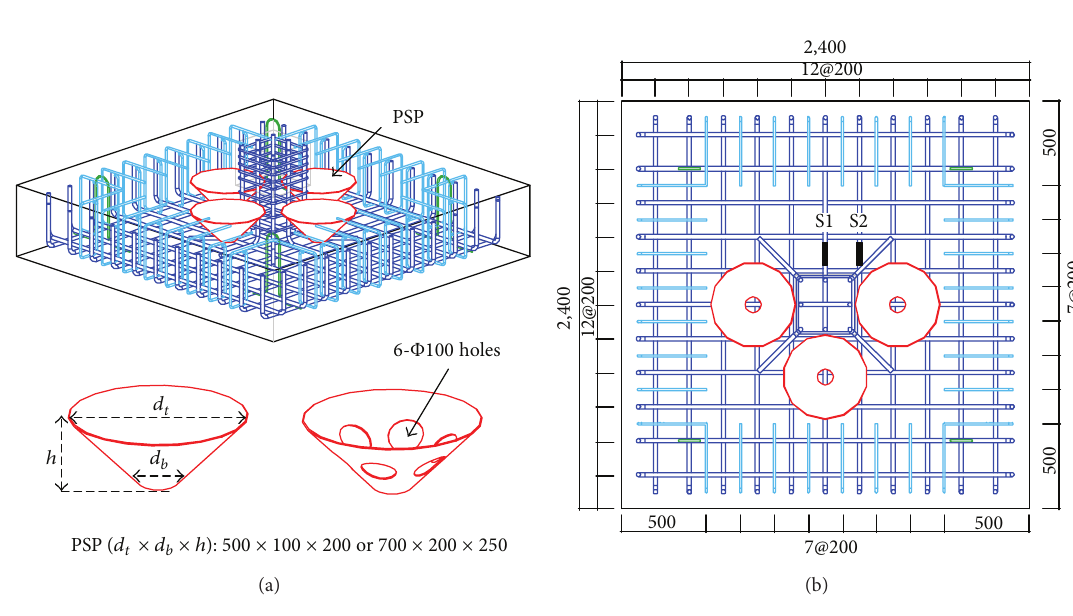
Figure 3: Reinforcement and PSP layout for the test